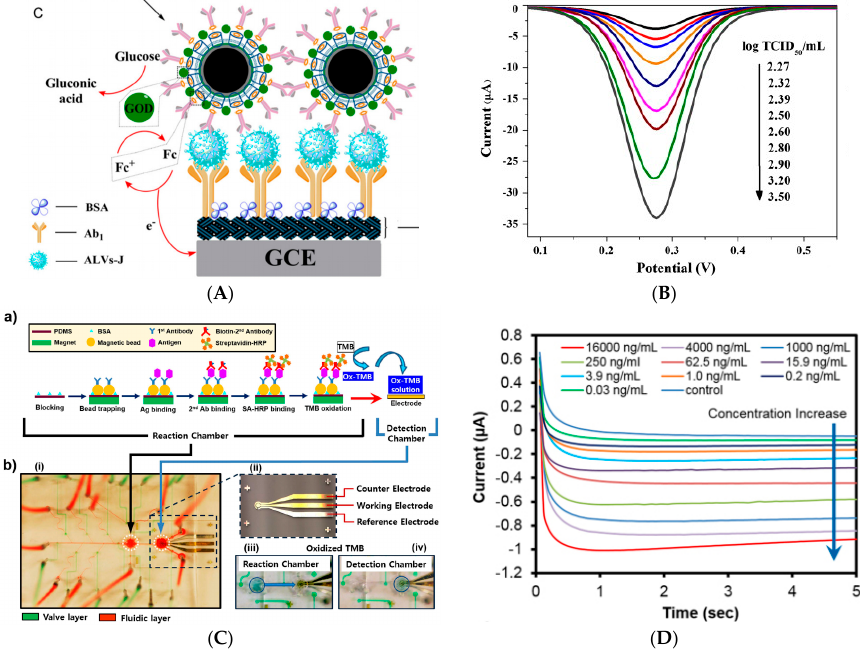
Figure 27. ( A ) Architecture of the magnetic Fe 3 O 4 -based immunosensor. MBs were decorated with GOx, signaling Abs and Fc-labeled β -CD. Capture Abs were grafted on GR sheets; ( B ) DPV at pH 7.0 Dependency of the DPV response towards different avian leukosis virus concentrations. Reprinted